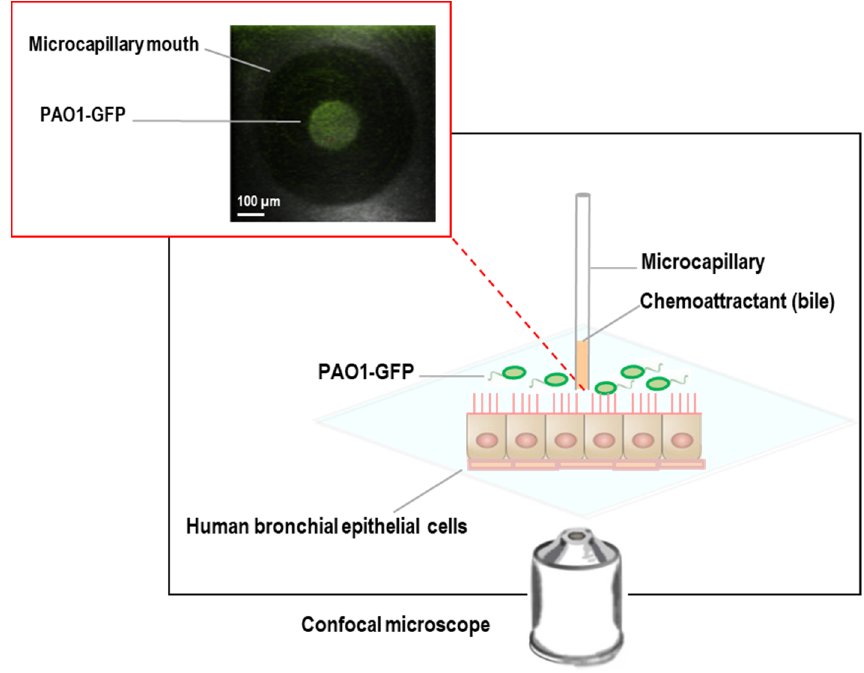
Figure 1. Human bronchial epithelial cell-bacteria chemotaxis system. The inset illustrates chemoattraction of green fluorescent protein (GFP)-labeled P. aeruginosa PAO1 (PAO1-GFP) cells towards bile.